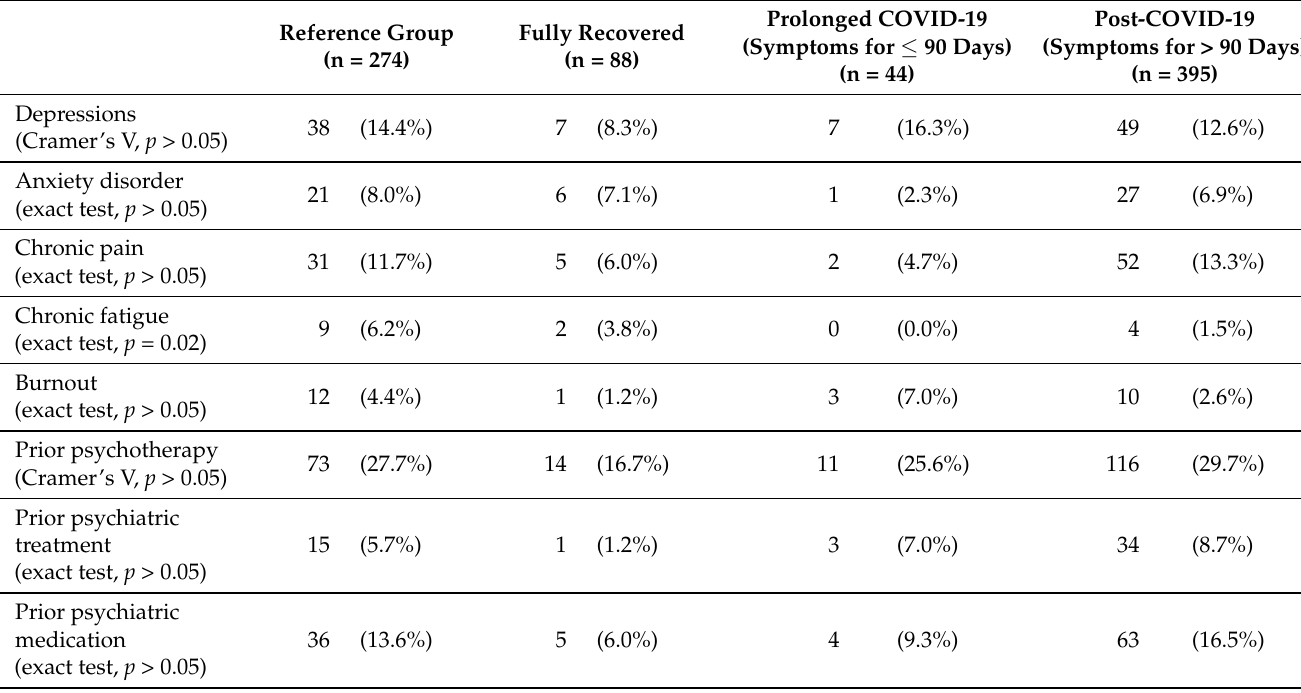
Table 2. Psychological health status prior to the